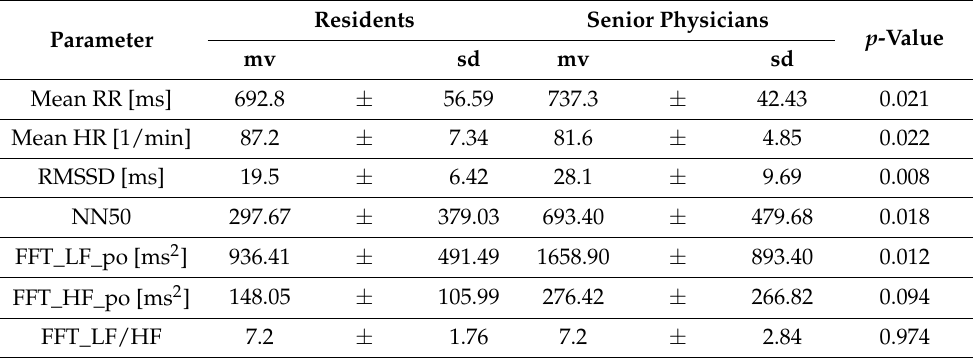
Table 2. Comparison of selected time-related HRV parameters as well as parameters from FFT analysis during ACB interventions in the cannulation to decannulation phase between the operating residents ( n = 15) and the assisting senior physicians ( n =